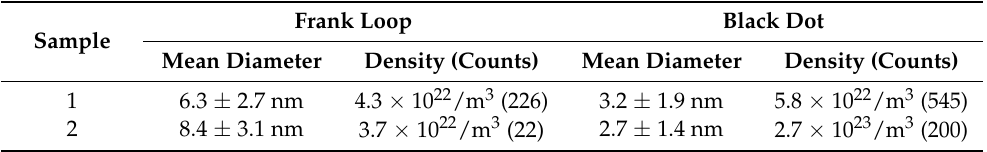
Table 2. Mean diameters and volume number densities of FLs and